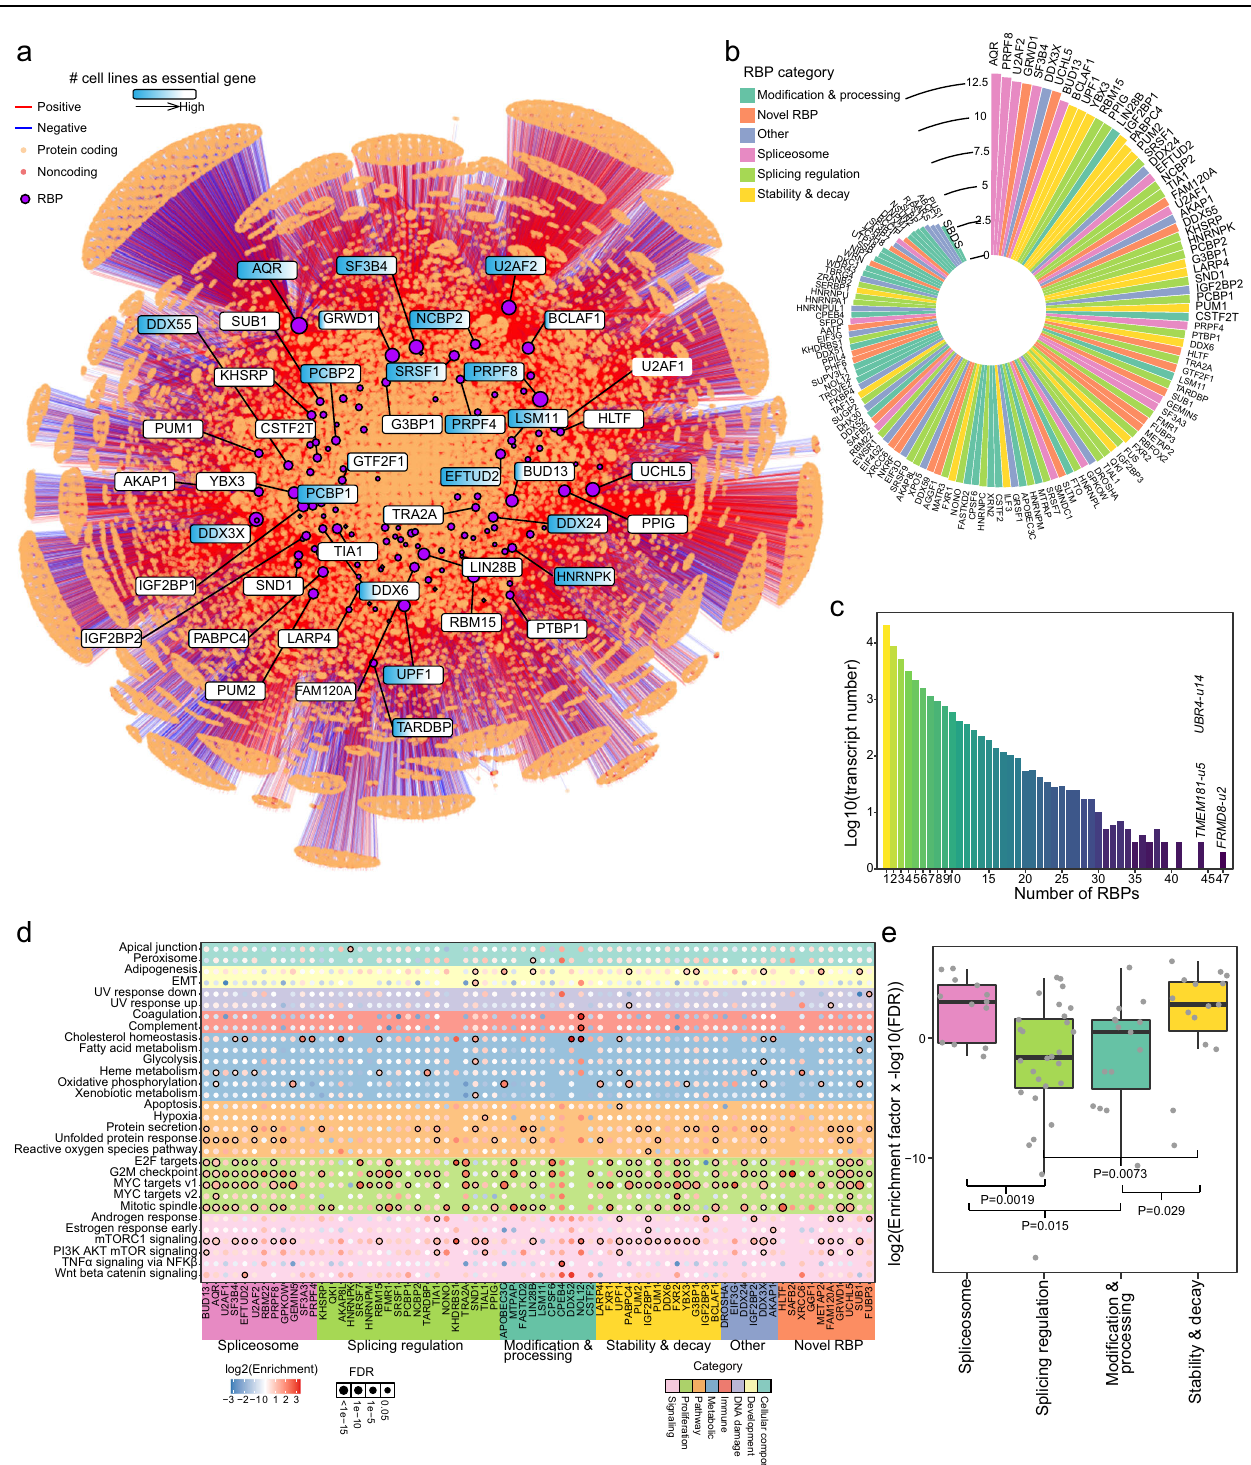
e Comparisons of enrichment among different categories of RBPs ( n =13 RBPs for “ spliceosome ” category, n =28 for “ splicing regulation ” category, n =15 “ mod- i fi cation & processing ” category, n =15 for “ stability & decay ” category). Each box represents the IQR and median of enrichment scores for each category, whiskers indicate 1.5 times IQR. P , two-sided Wilcoxon ’ s rank-sum test p